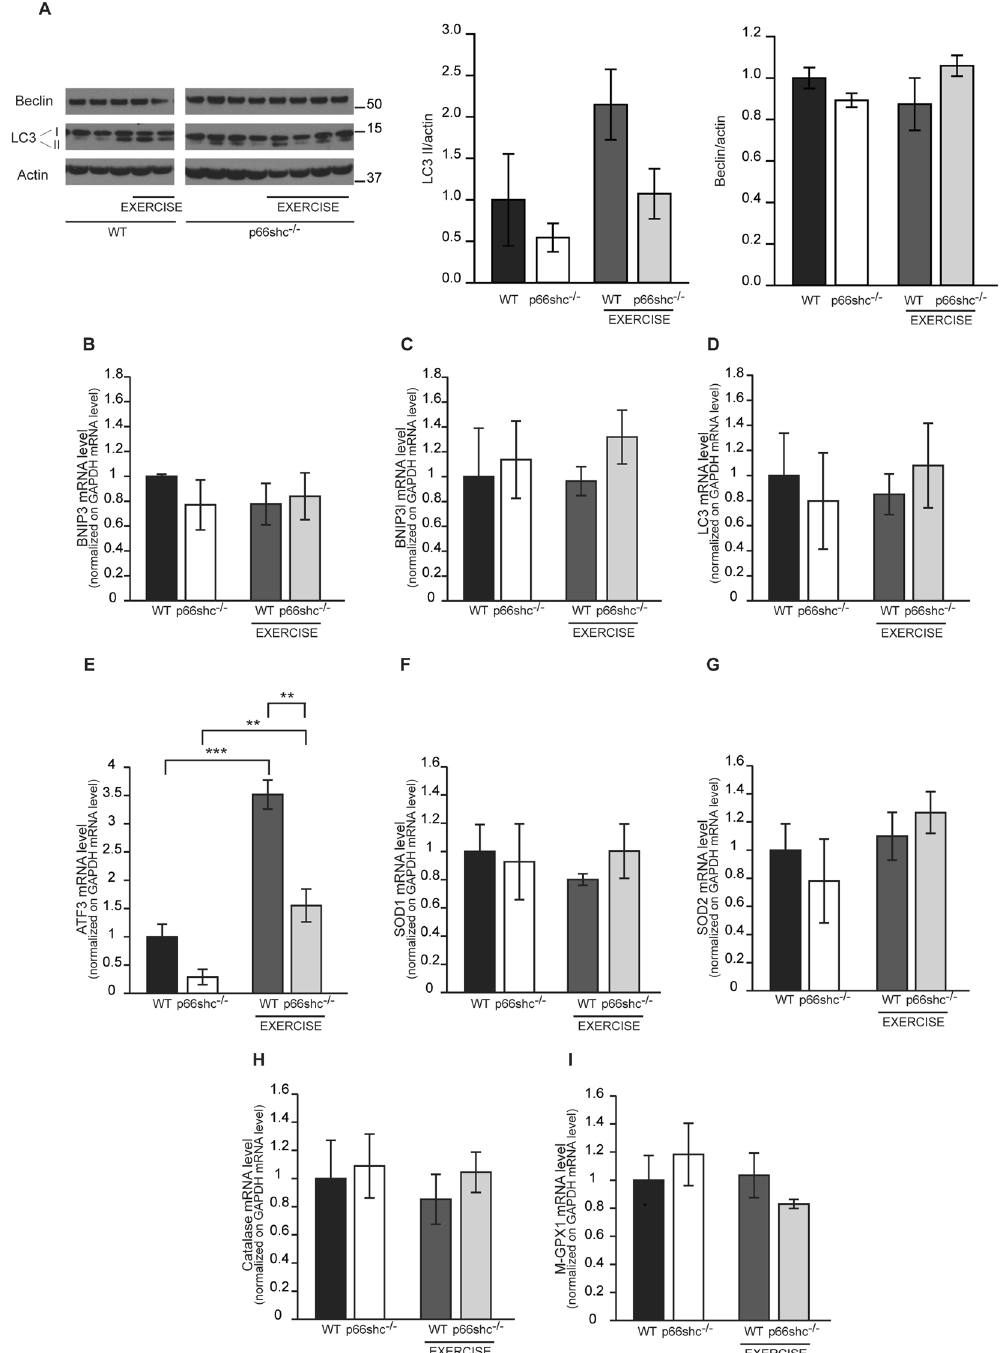
Figure 7. Analysis of signaling pathways in wt and p66shc − / − HFD-treated mice. ( A ) Immunoblotting of muscles of wt and p66shc − / − mice fed with HFD for 9 month before and immediately after (exercise) a single bout of exhaustion running and quantification by densitometry. Data are presented as mean ± SEM (3–4 animals per group). Cropped blots are displayed, and full-length blots are presented in Supplementary Figure S1. ( B – I ) qRT-PCR for Bnip3 ( B ), Bnip3l ( C ), LC3 ( D ), ATF3 ( E ), SOD1 ( F ), SOD2 ( G ), Catalase ( H ) and M-GPX1 ( I ) transcripts. Data are normalized on GAPDH mRNA level. ** p < 0.01, *** p < 0.005, pairwise multiple comparison (Holm-Sidak method)of 4 animals per condition. Data are presented as mean ±